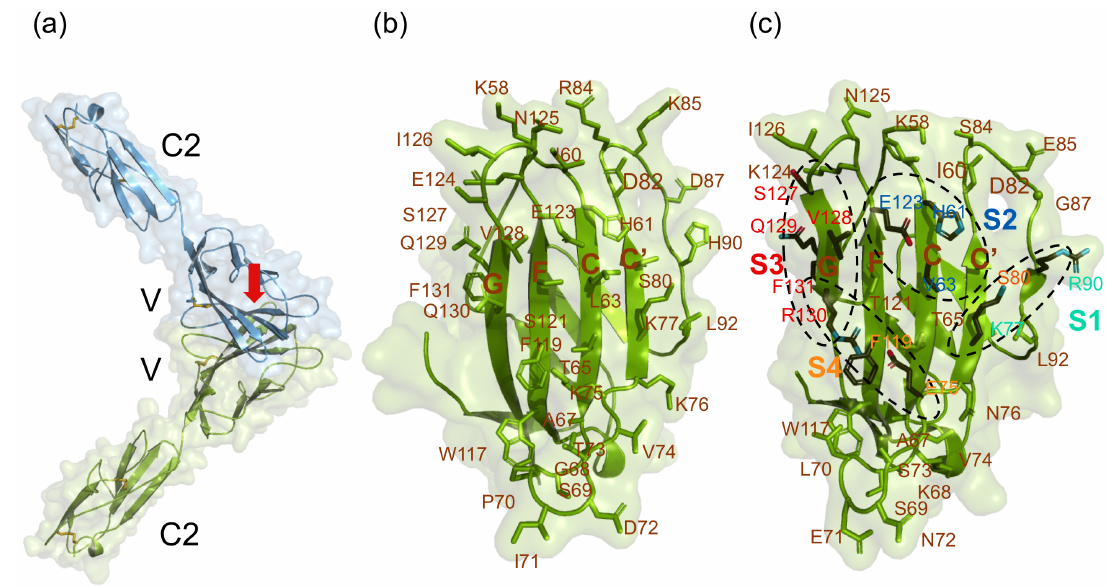
Figure 3. Ribbon representation of the three-dimensional (3D) structures of signaling lymphocyte activation molecules (SLAMs) from killer whales ( Orcinus orca ) and cotton-top tamarins ( Saguinus oedipus ). The 3D models were constructed by homology modeling based on the crystal structure of the complex between MV-H and the cotton-top tamarin SLAM-V [148,150]. ( a ) Blue and green models show the two SLAM extracellular domains of killer whales forming a homophilic dimer. β -strands are indicated by blue and green arrows and disulfide bonds are shown as yellow lines. The red arrow indicates the direction of view of the interface for morbillivirus binding as shown in ( b ) and ( c ). ( b ) Interface of the killer whale SLAM from the view of the red arrow in ( a ). Four β -strands are indicated as C, C’, F, and G. The amino acids that potentially interact with the viral H protein are shown along with their position numbers. The amino acid positions correspond to those of the MV-H–SLAM-V crystal structure [148]. ( c ) As a reference, the cotton-top tamarin SLAM interface is shown. The four binding sites (S1–S4) present in the crystal structure [148] are marked with dotted circles. The residues involved in these four binding sites are colored di ff erently (site 1—mint green; site 2—cyan; site 3—red; site 4—orange) with colored atoms (black for carbon, blue for nitrogen, and red for oxygen). This figure was modified from Shimizu et al.